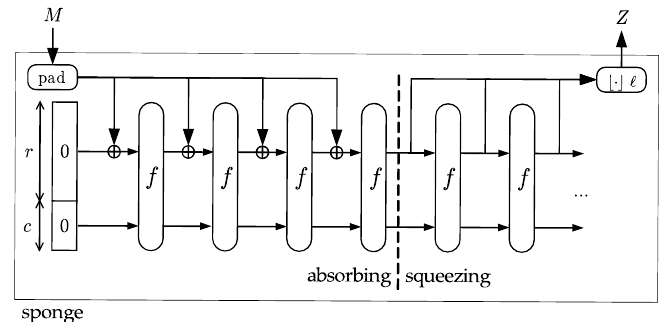
Figure 1: The sponge construction.